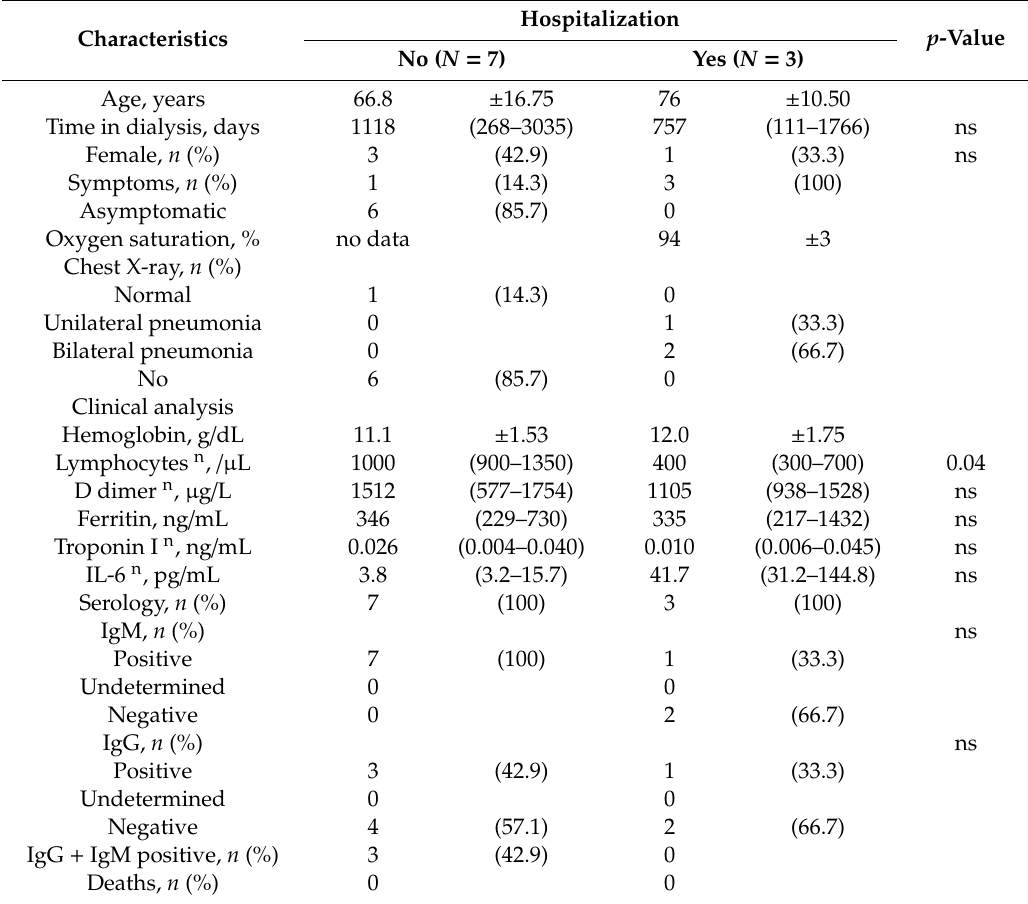
Table 3. Analysis of polymerase chain reaction (PCR) negative patients according to hospitalization related to disease severity. Data presented as mean ± SD, median (interquartile range) or counts